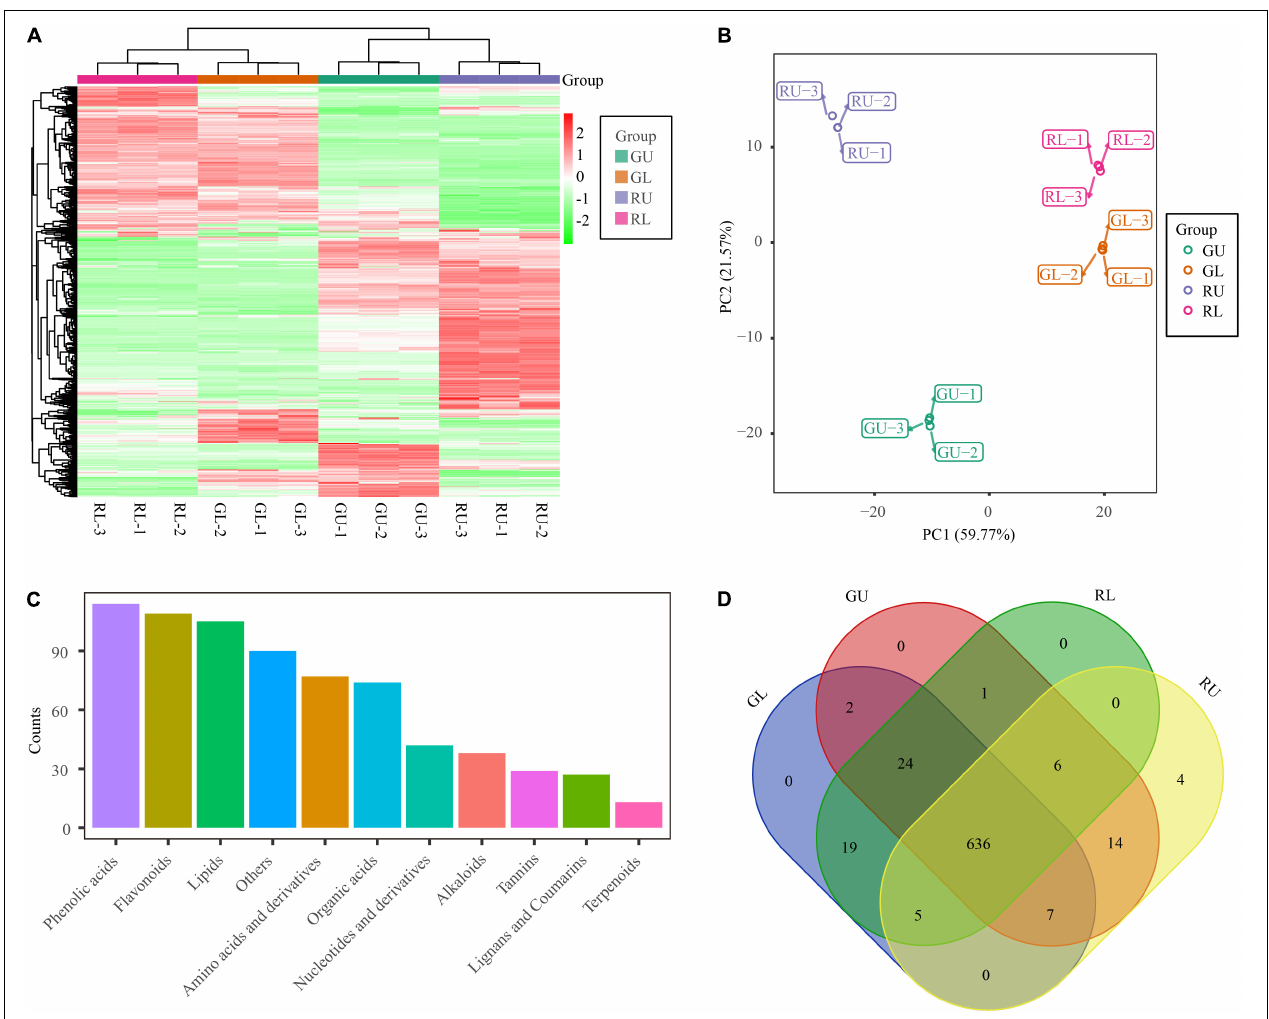
FIGURE 2 | Metabolites of H. hainanensis . (A) Heatmap of metabolites distributed in all samples and replicates. (B) PCA analysis of metabolites. (C) Abundance of different metabolite types from all samples. (D) Venn diagram of metabolites from all